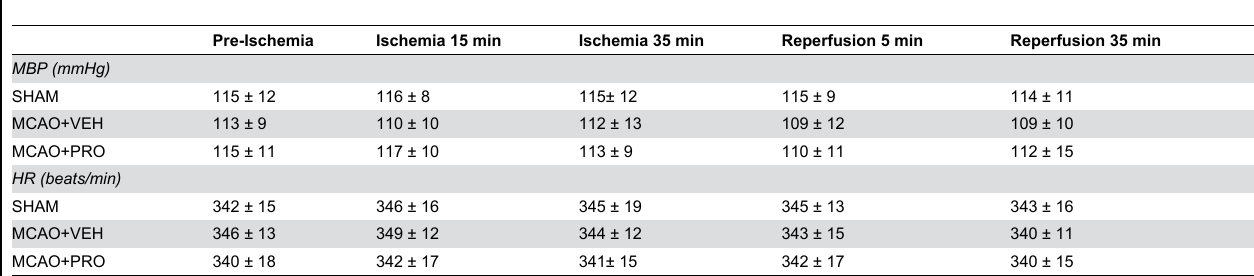
Table 2. Systemic hemodynamic variables during MCAO and reperfusion.